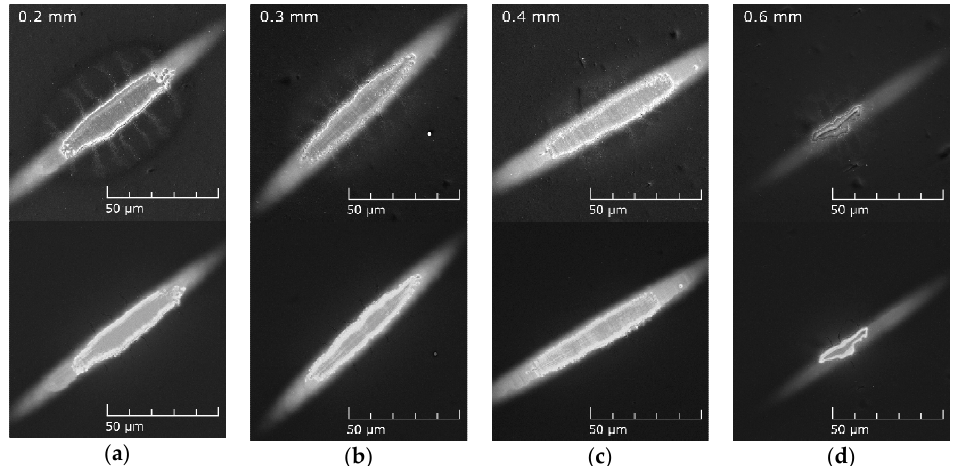
Figure 8. The effect of the sample distance from DCSBD plasma layer, and H 2 plasma treatment time on the mechanism of the etching of polymer mesh foil.